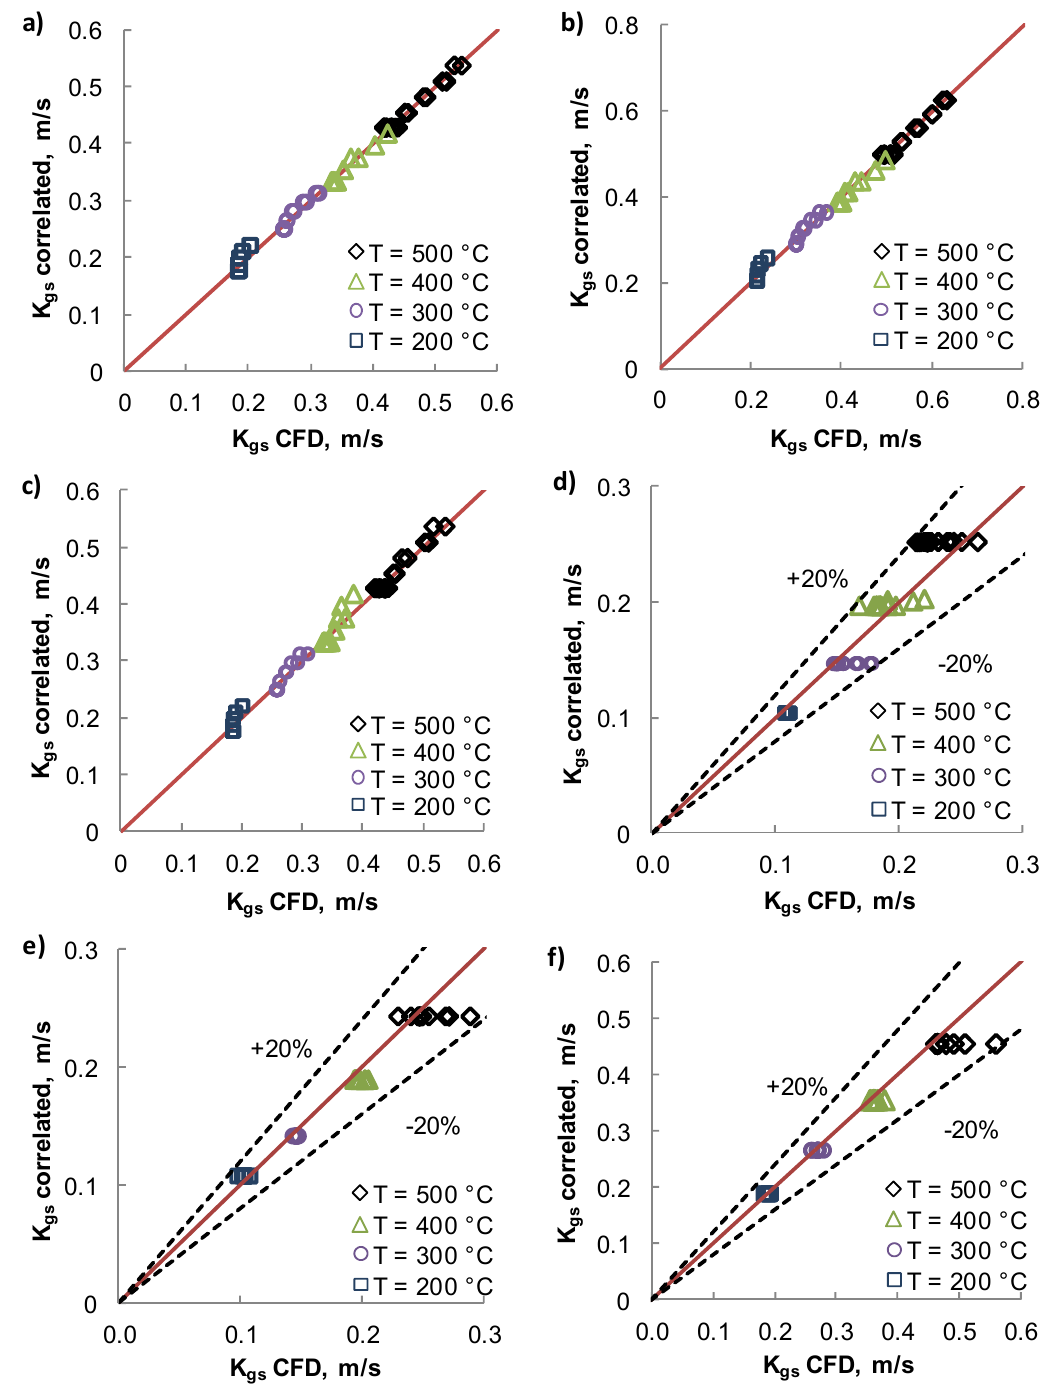
Figure 3. Parity plot for the asymptotic values that the K gs profiles stabilized at all the tested conditions. Cell diameter d = 1.1 mm. ( a ) CO, ( b ) NO, ( c ) O 2 , ( d ) C 3 H 6 , ( e ) C 3 H 8 and ( f ) CH 4 .